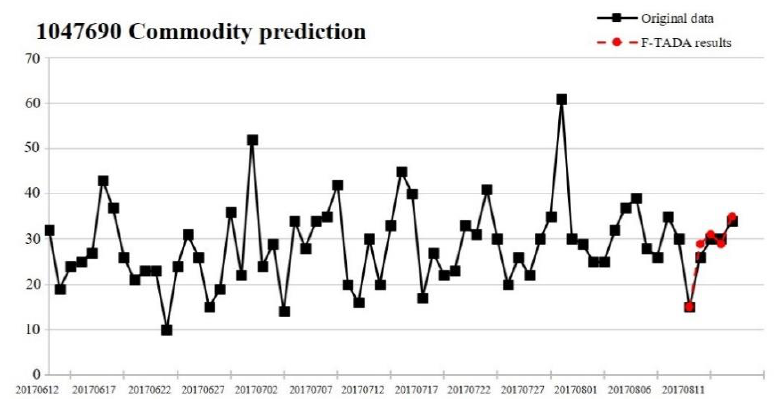
Figure 7. Results of 1047690 commodity data.